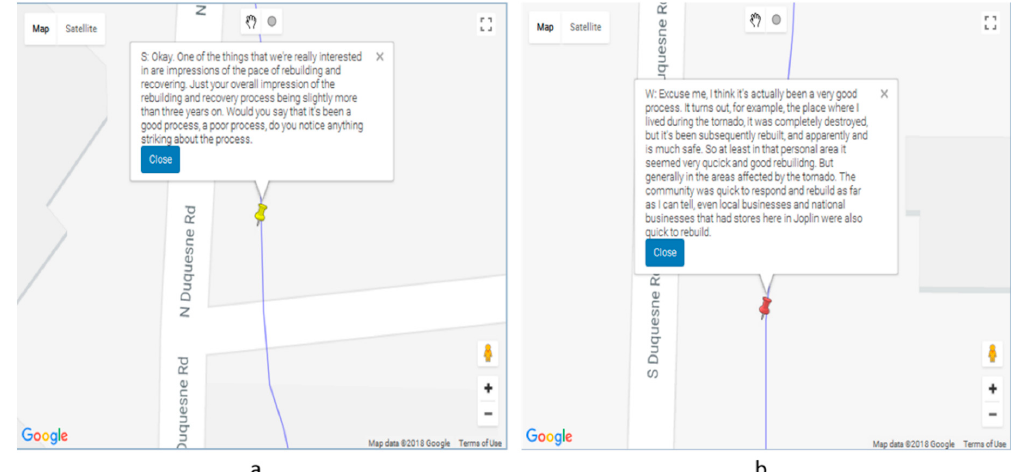
Figure 7. Wordmapper visualization module showing the ( a ) narrative sentence for the keyword ‘recover*’ and ( b ) response by the interviewee about recovery without using the word ‘recover’.